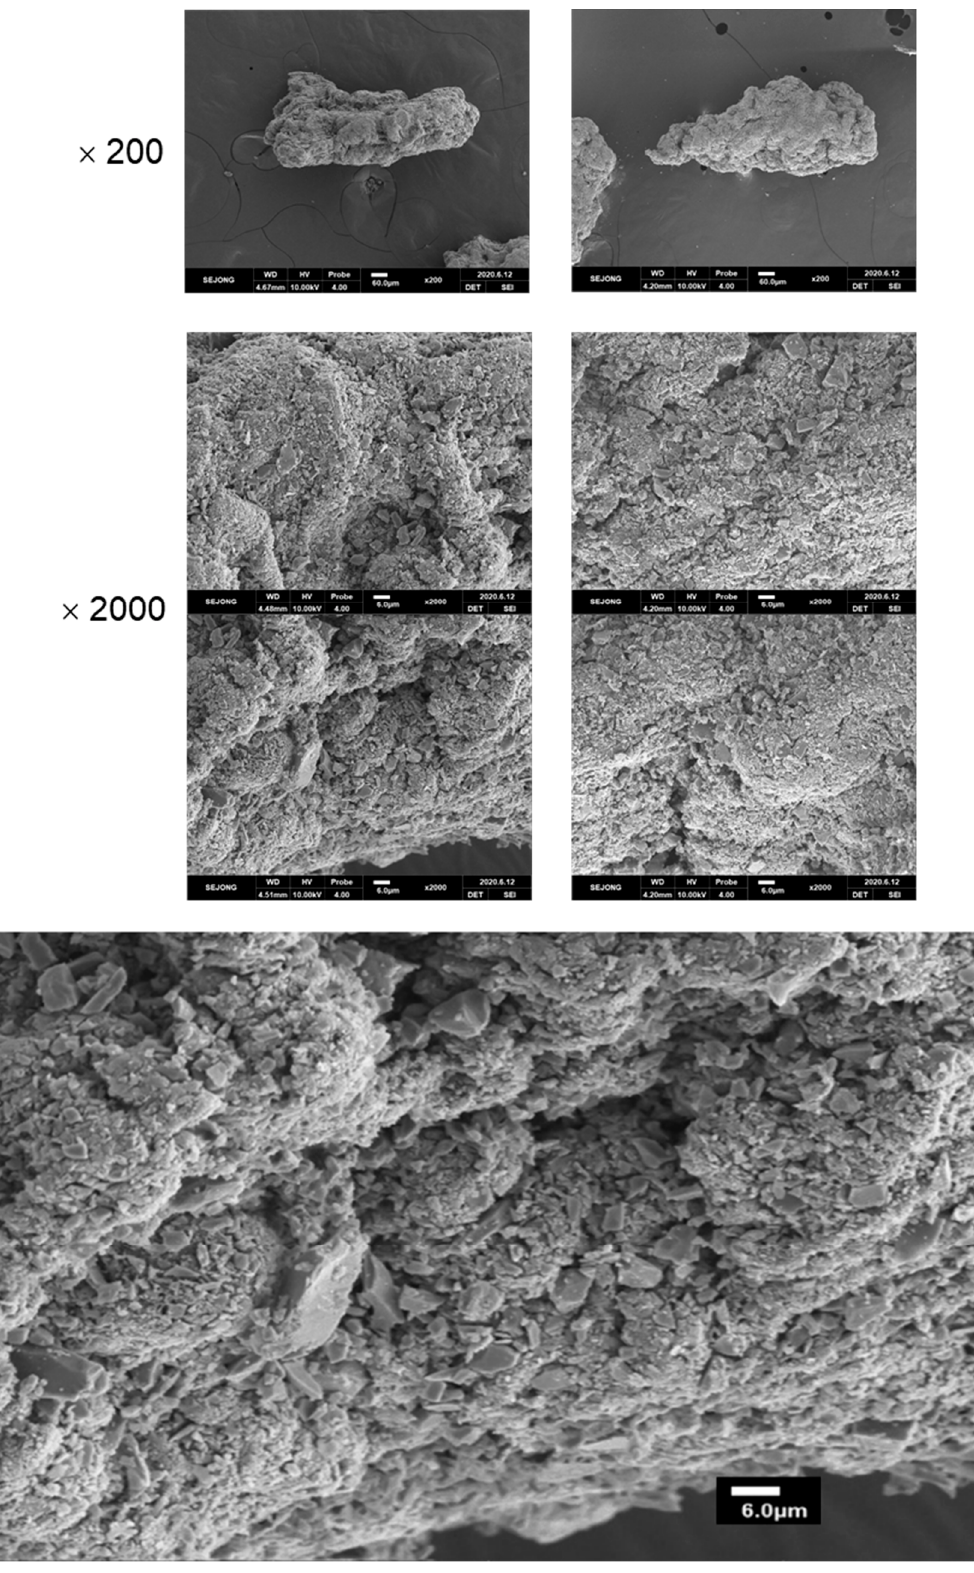
Figure 3. SEM images of the model TRWPs made of the chloroform-treated TWP by the double step pressing procedure. The scale bars are 60 and 6 μ m for the magnifications of 200 and 2000, respectively.